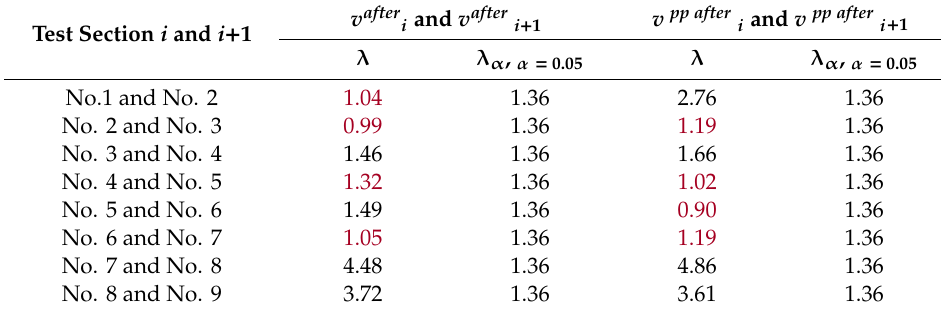
Designations colour in the table results of goodness-of-fit test (free speed): H 0 : F ( v after i ) = F ( v after i + 1 ) → λ < λ α ;